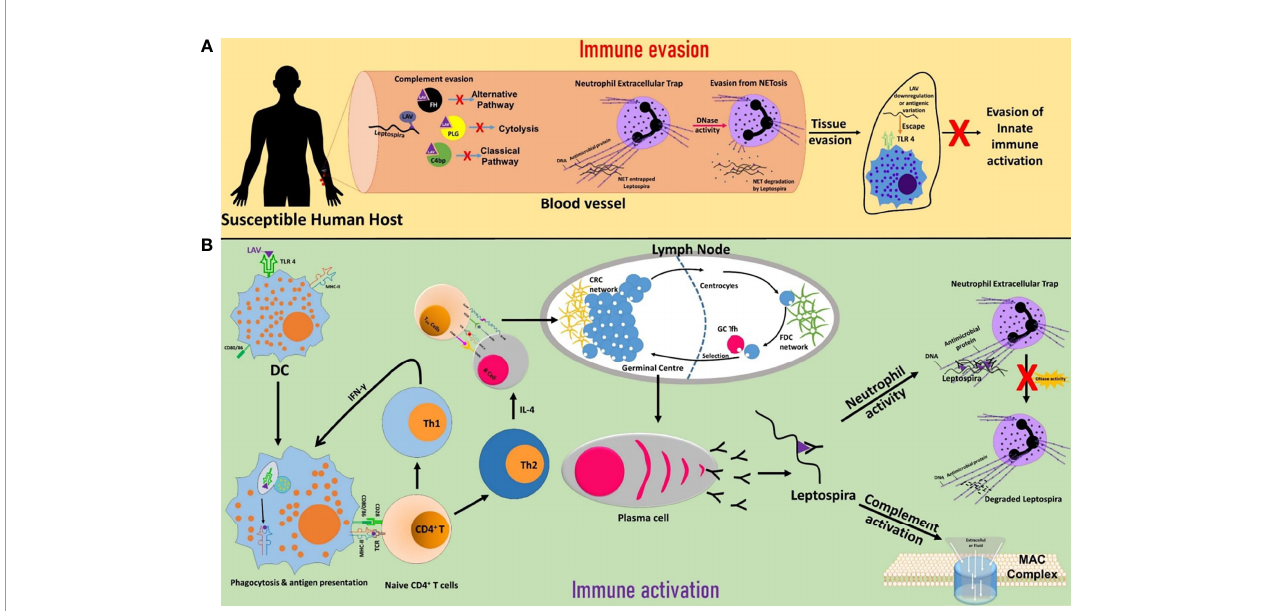
FIGURE 7 | Schematic presentation of the role of LigA in the modulation of host immune response. (A) Immune evasion. LigA expressed during infection might acquire complement regulators (FH, C4BP, PLG) to inhibit both the classical and alternate pathways of complement-mediated killing. Leptospira might utilize the nuclease activity of LigA to escape from NET. Upon interaction with host innate immune cells (DCs, macrophages), LigA might undergo antigenic variation or downregulate its expression to evade recognition through TLR4 and subsequent activation of the innate response. (B) Immune activation. LigA can activate strong innate and adaptive immune responses leading to the production of antibodies that may block binding to complement regulators, inhibit nuclease activity and enhance phagocytosis, all of which may contribute to the killing of bacteria and clearance from the